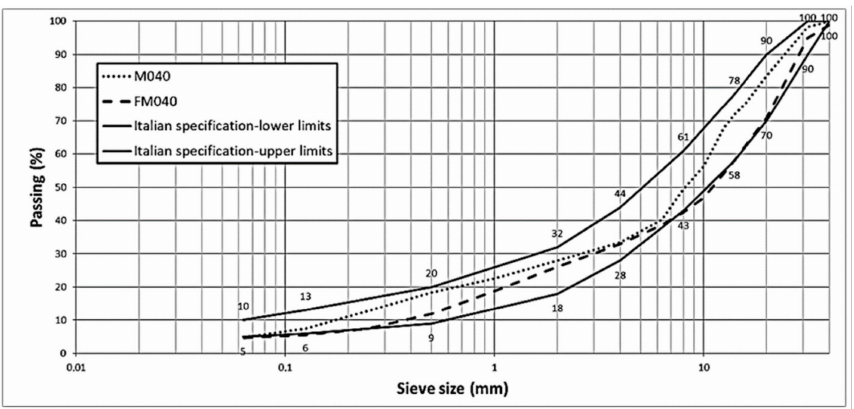
Figure 4. M040 and FM040 gradations.